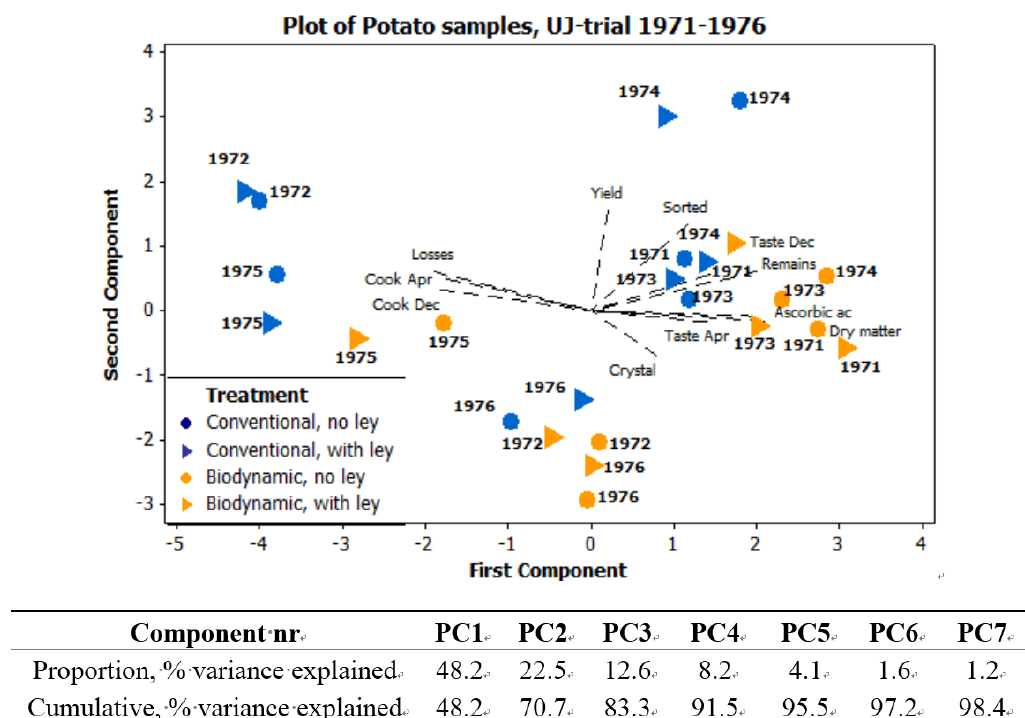
Figure 6. PCA plot of mean values, without the core variables and other variables closely correlated to the core variables, from potato samples. UJ-trial 1971–1976. Bolded numbers indicate harvest